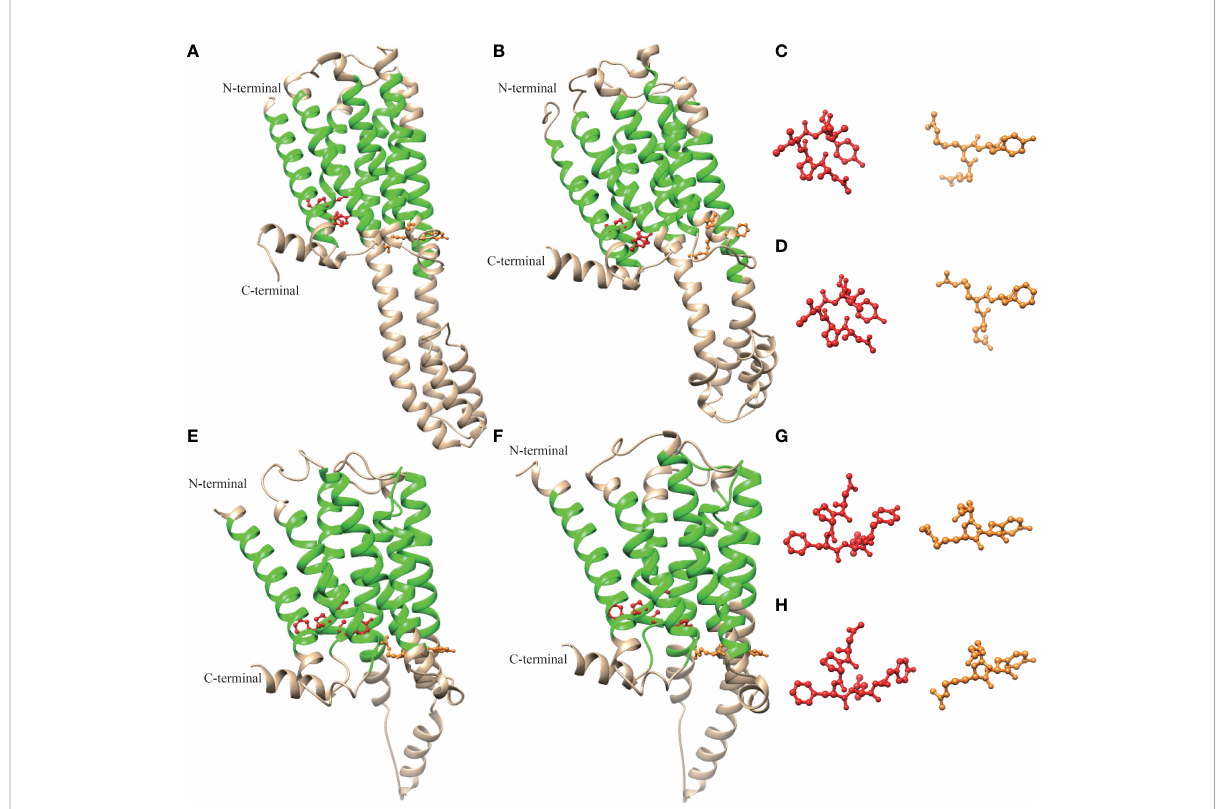
FIGURE 3 Molecular model of the three-dimensional structure of Pm5-HTR2 (A) , Mg-HTR2 (B) (VDI68244.1), Pm5-HTR4 (E) , and Cg5-HTR4 (F) (XP_011430667.2). The ERY/DRY and NPXXY motifs are shown in orange and red, respectively. Panels (C, D, G, H) show the ERY/DRY and NPXXY motifs of panels (A, B, E, F) ,